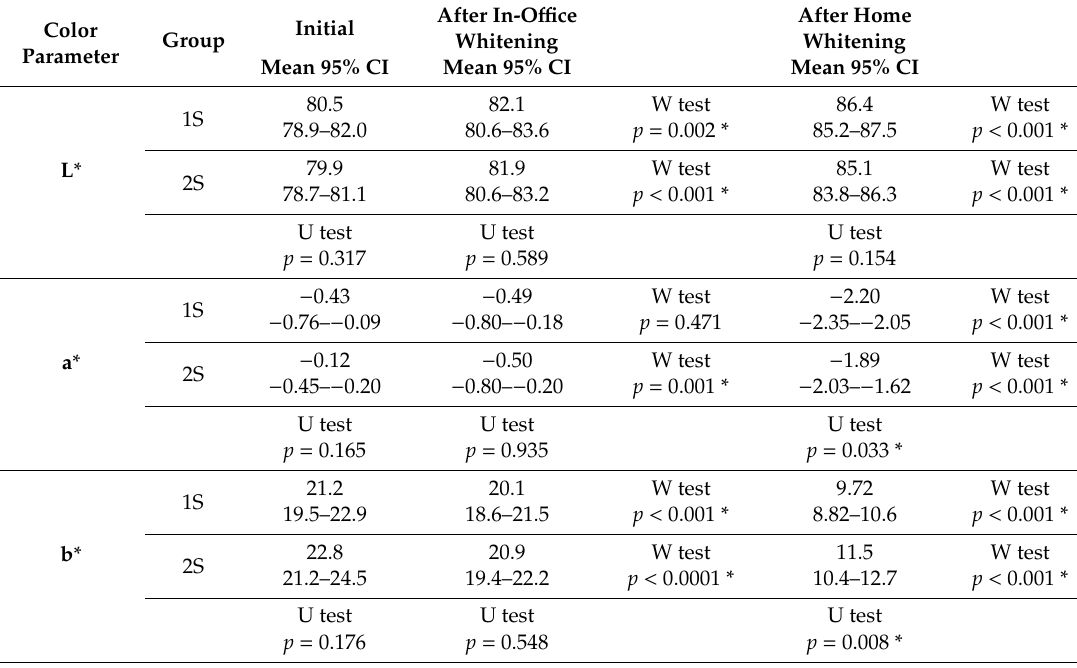
Table 3. Values of color parameters L*, a* and b* after in-o ffi ce whitening and home whitening in relation to the number of in-o ffi ce sessions (one or two). Mann–Whitney U test applied to identify intergroup di ff erences; Wilcoxon test applied to identify intragroup di ff